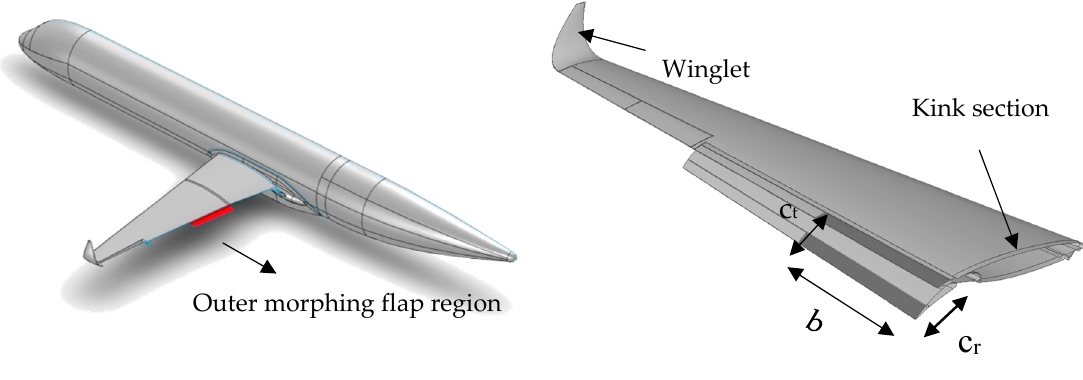
Figure 1. Reference wing for Clean Sky ‐ JTI outer flap.